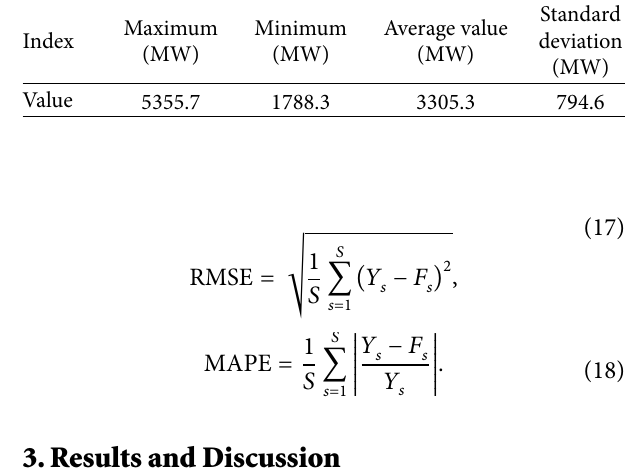
Table 1: Basic information of the load